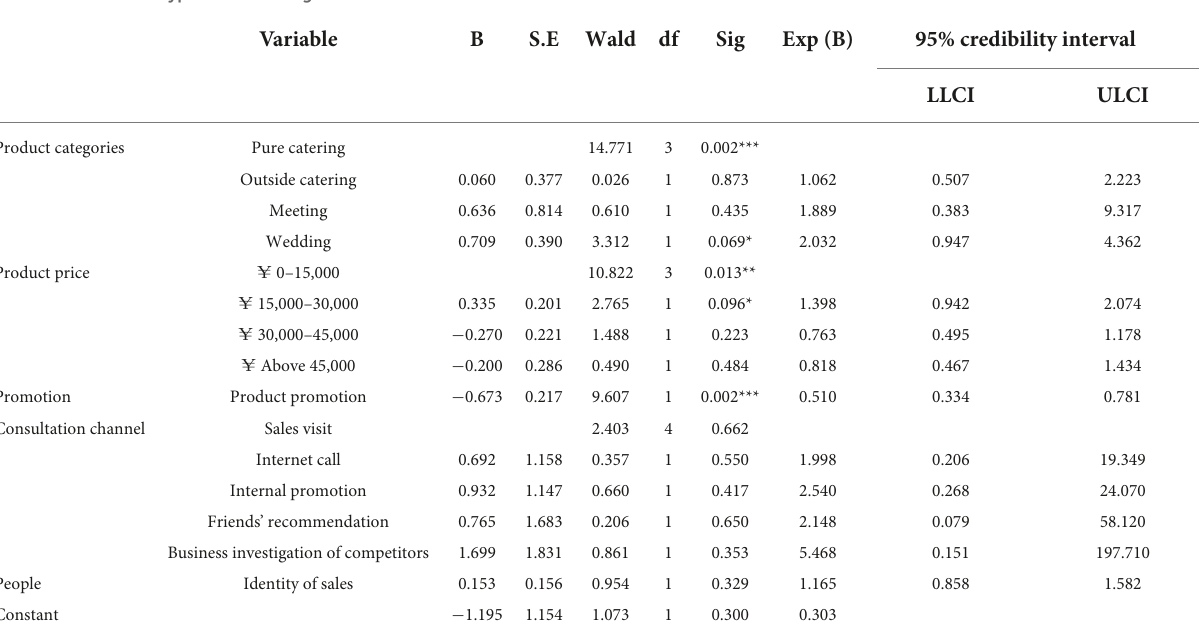
TABLE 2 Results of hypotheses